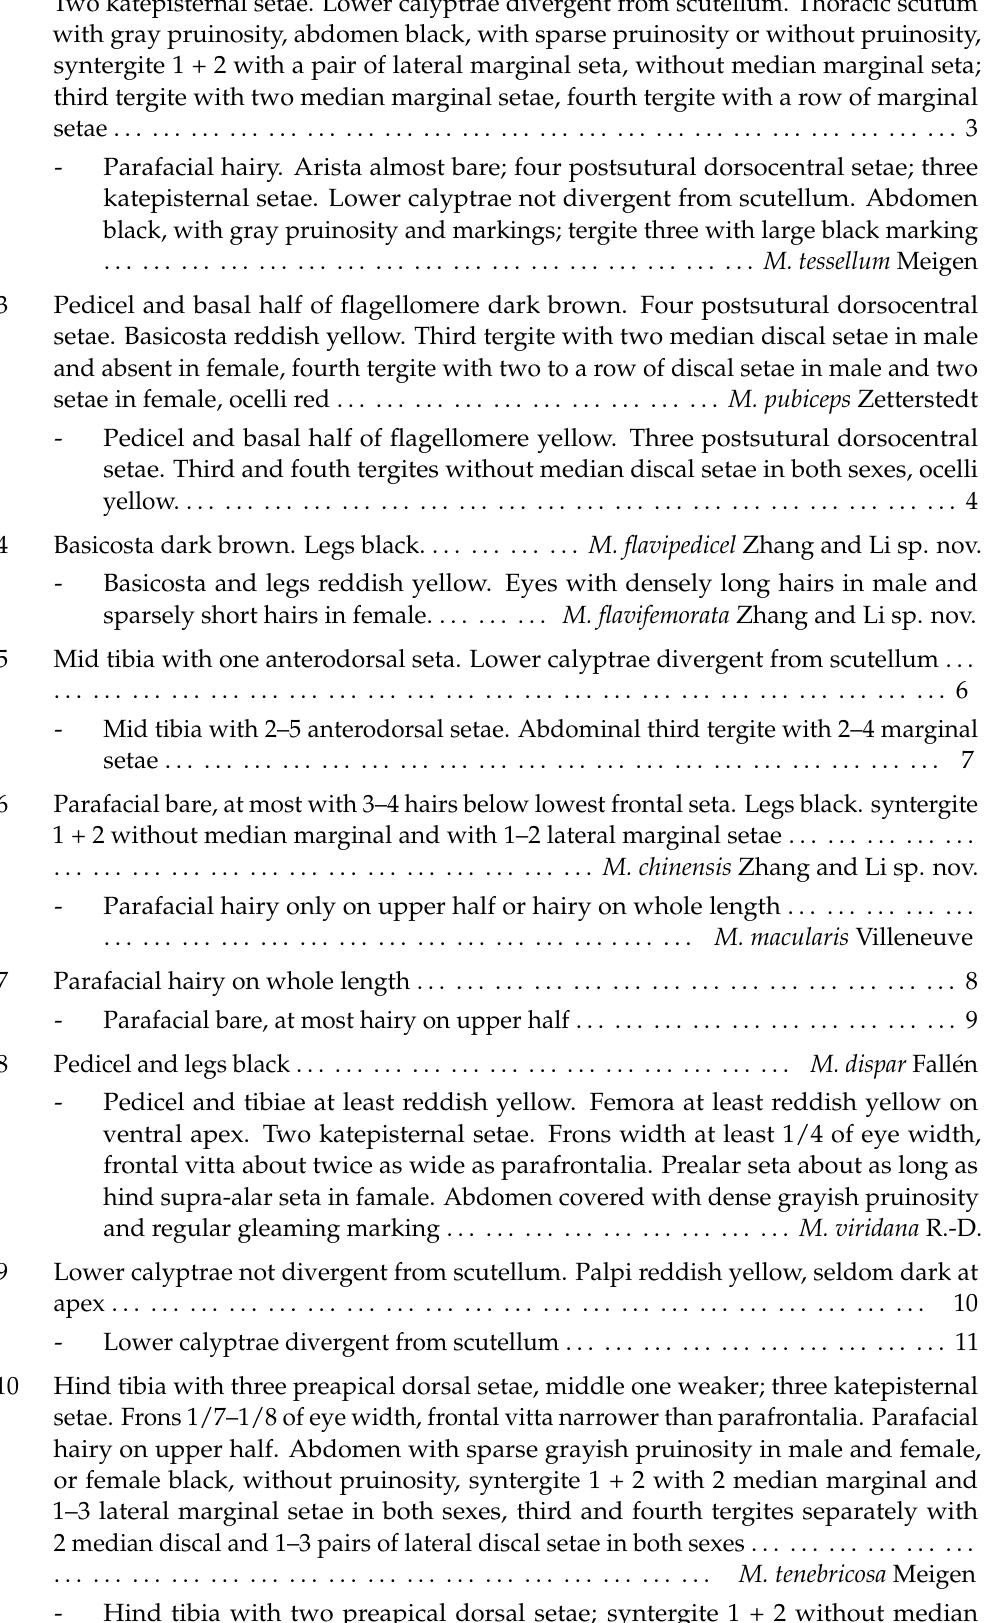
10 Hind tibia with three preapical dorsal setae, middle one weaker; three katepisternal setae. Frons 1/7–1/8 of eye width, frontal vitta narrower than parafrontalia. Parafacial hairy on upper half. Abdomen with sparse grayish pruinosity in male and female, or female black, without pruinosity, syntergite 1 + 2 with 2 median marginal and 1–3 lateral marginal setae in both sexes, third and fourth tergites separately with 2 median discal and 1–3 pairs of lateral discal setae in both sexes . . . . . . . . . . . . . . . . . . Hind tibia with two preapical dorsal setae; syntergite 1 + 2 without median marginal seta. Abdomen of female covered with covered grayish pruinosity,